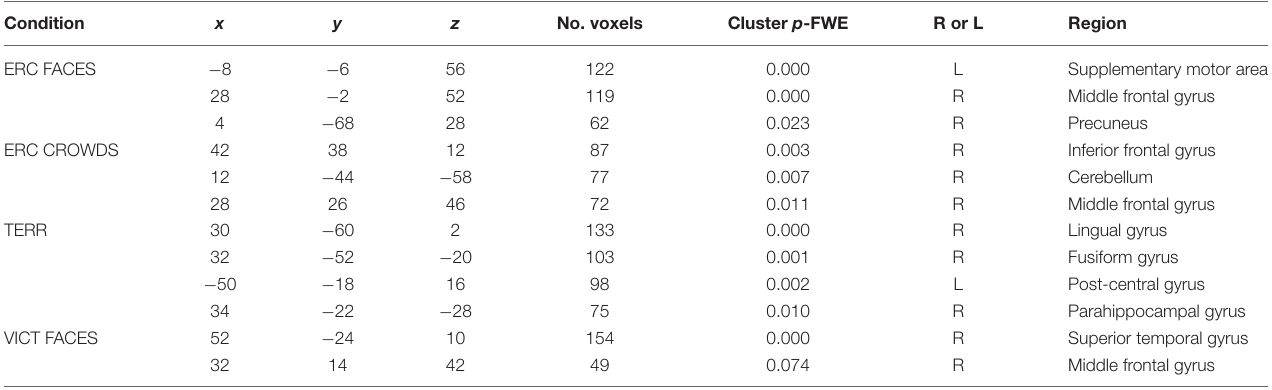
TABLE 3 | Functional connectivity analysis of the left fusiform gyrus seed. Condition x y z No. voxels Cluster p -FWE R or L Region ERC FACES − 8 − 6 56 122 0.000 L Supplementary motor